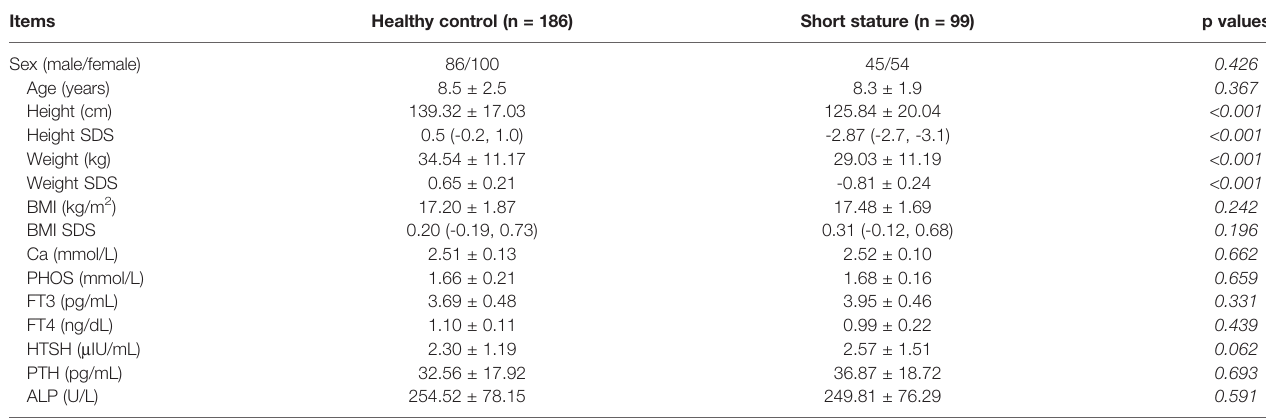
TABLE 1 | General characteristics of the study